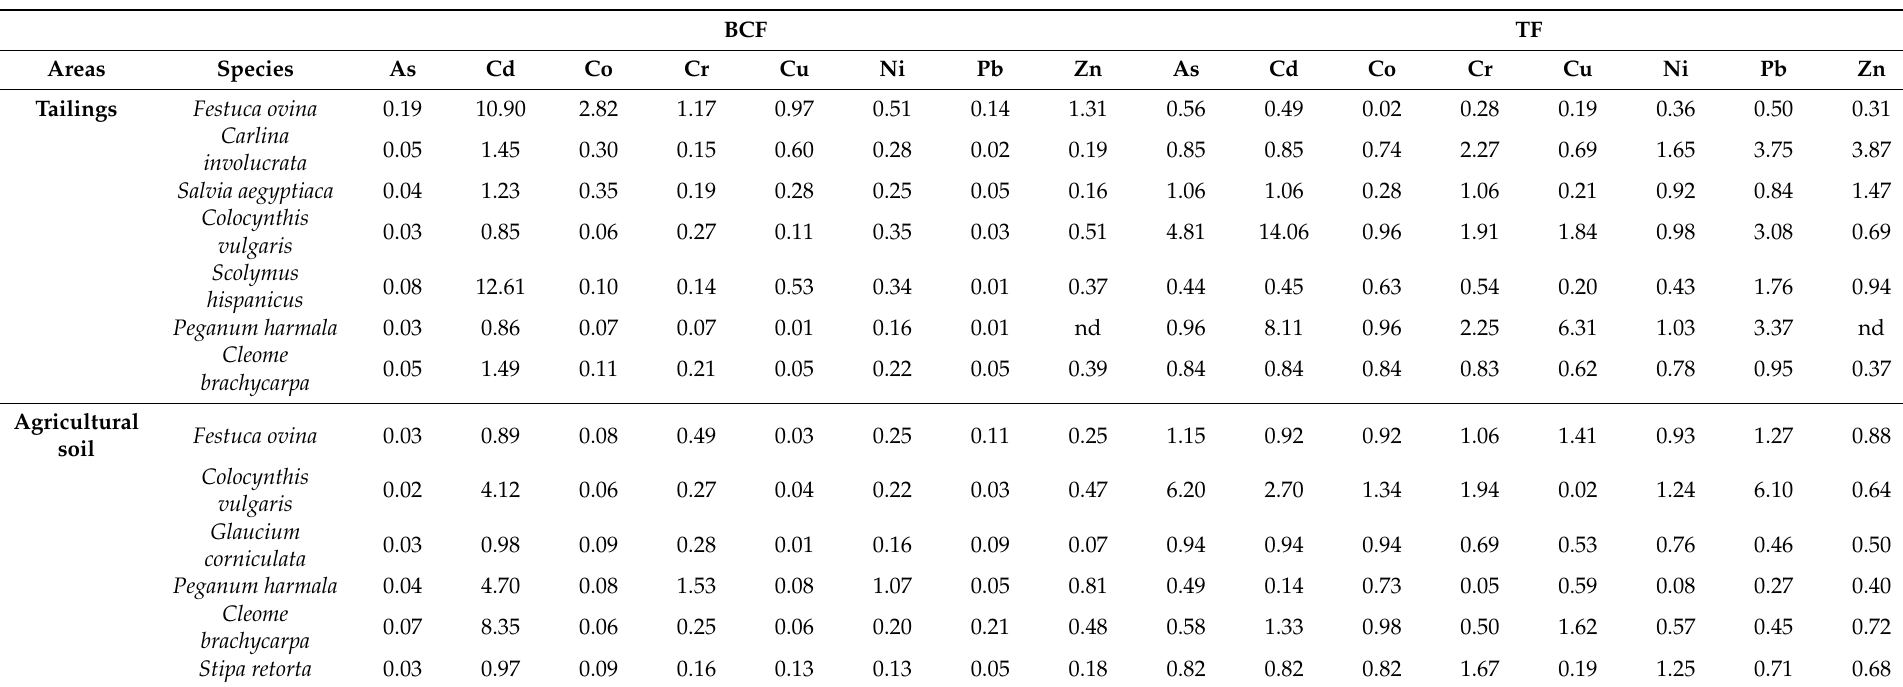
Table 2. Bioconcentration factor (BCF) and translocation factor (TF) of trace elements in the sampled species from the tailings and the agricultural soil. BCF